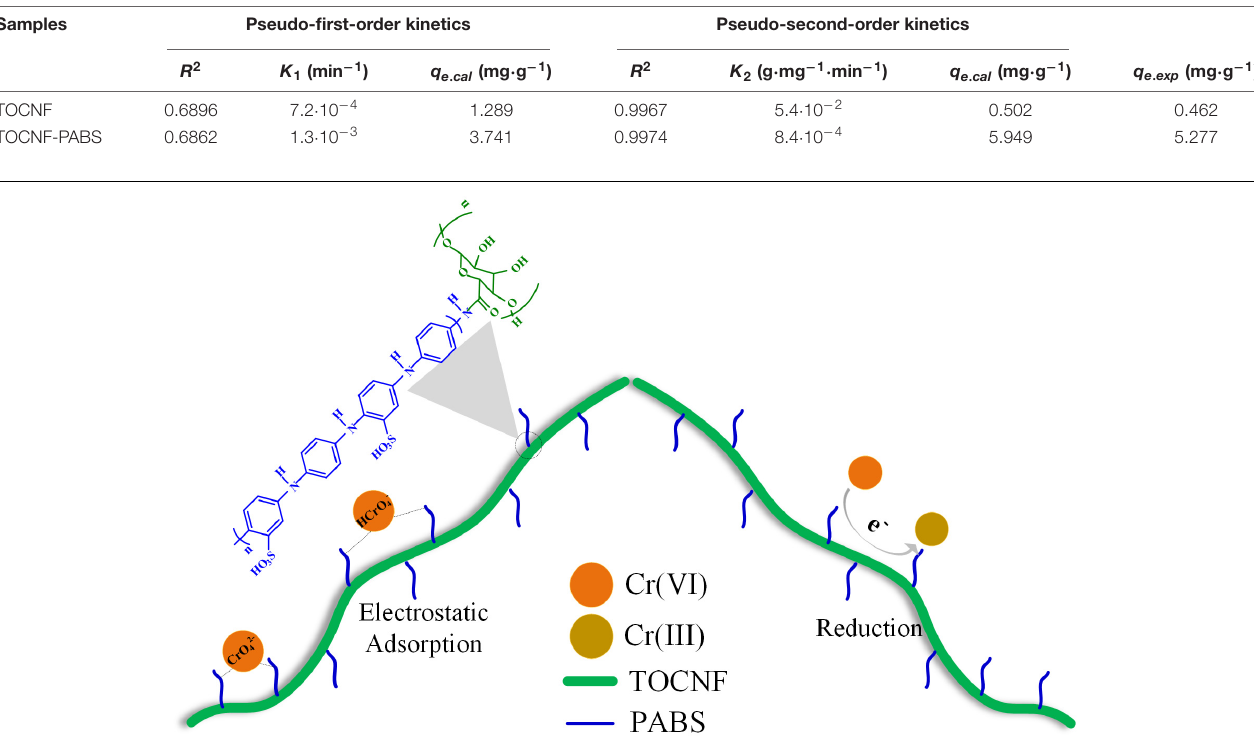
FIGURE 6 | Hypothetical adsorption mechanism of Cr(VI) onto TOCNF-PABS.